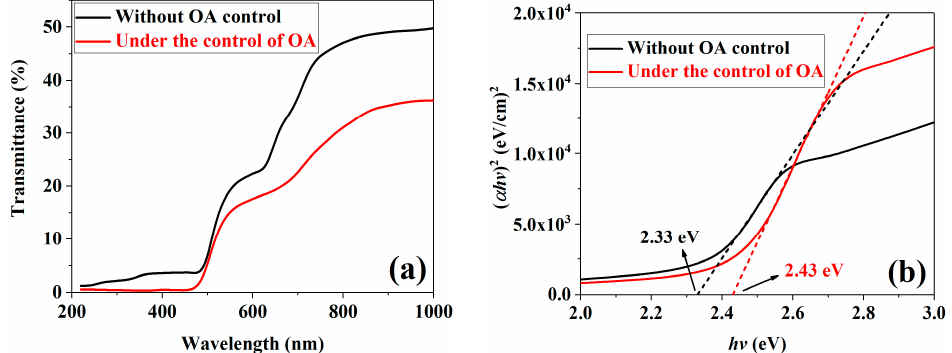
Figure 7. ( a ) UV-vis transmittance spectra of the DAST single crystals grown with and without the OA control; ( b ) Plots of ( α h ν ) 2 function against h ν with evaluation of the band gaps for various DAST single crystals.